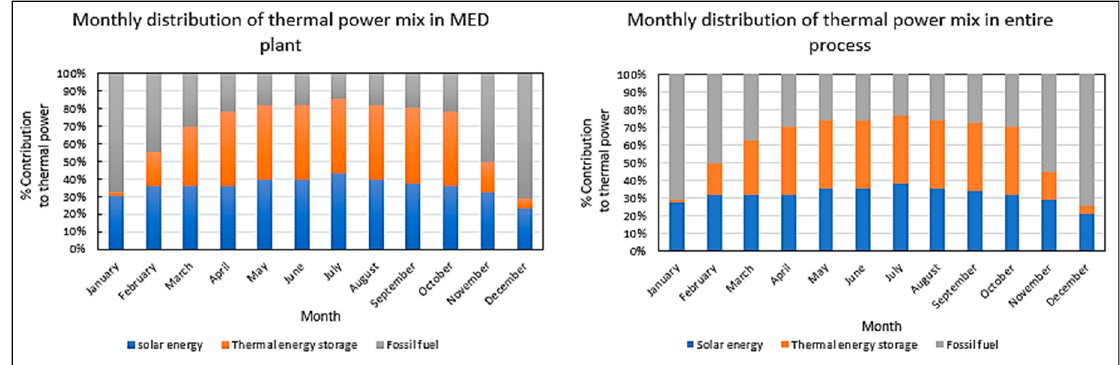
Figure 3. Monthly average of hourly direct normal irradiance (DNI) and useful thermal power.